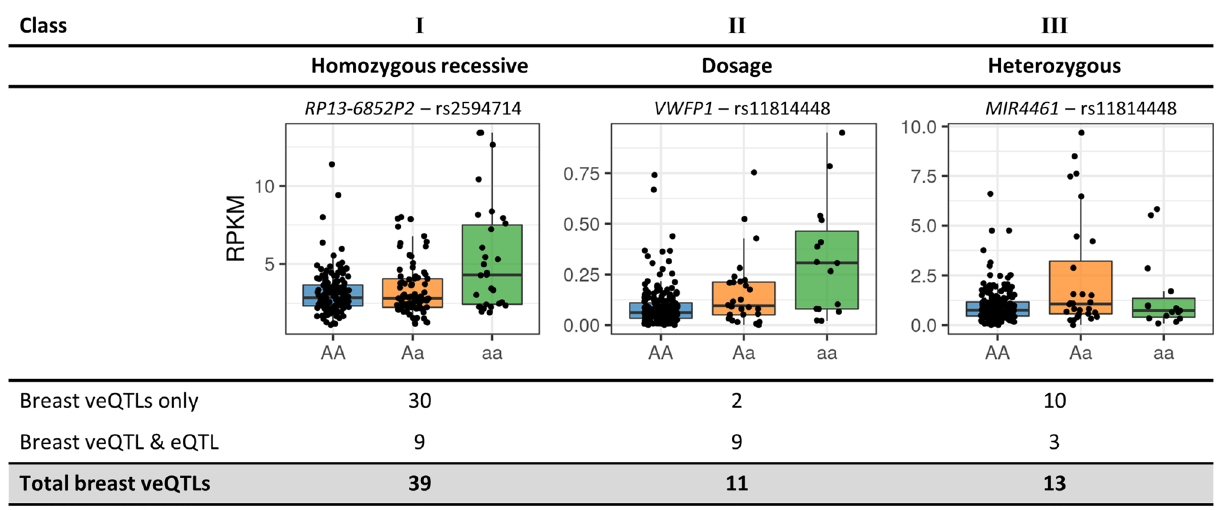
Figure 2. Characteristics of gene expression variability in veQTLs. Three class of veQTLs were observed with respect to the minor allele. Boxplots represent genes at veQTL for each of the proposed classes. Each point represent the expression of a single sample. The table (bottom) presents the number of significant veQTL associations categorised by class. Significant breast veQTLs were represented in all three classes with the majority (39/70) class I.